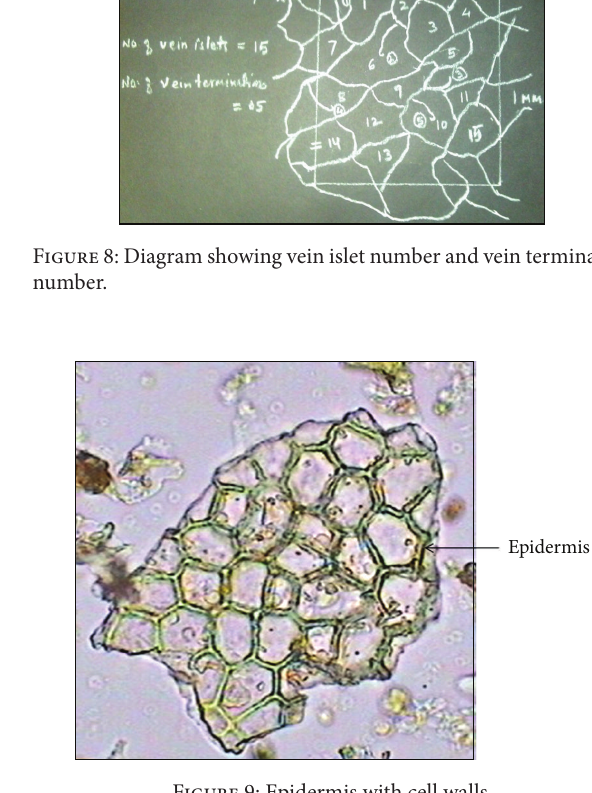
Figure 9: Epidermis with cell